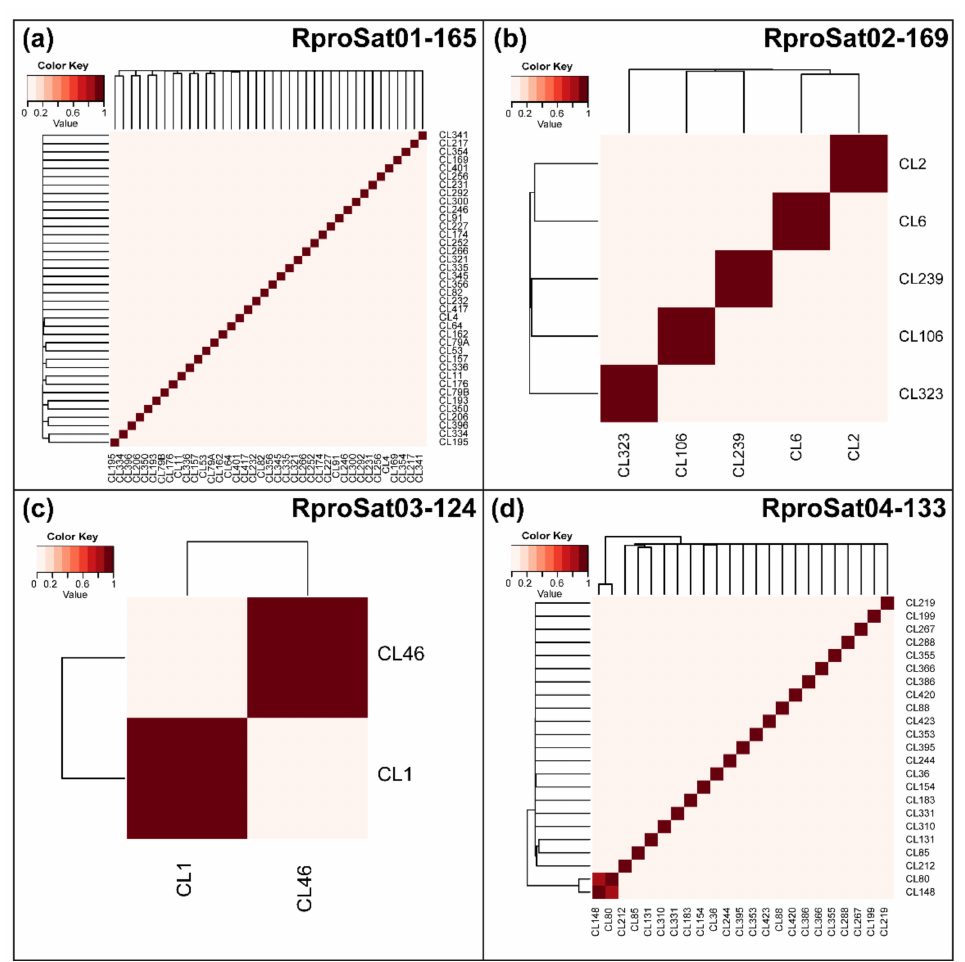
Figure 4. Heatmap representing the fraction of Rhodnius prolixus genome scaffolds shared by two subfamilies: ( a ) RproSat01- 165, ( b ) RproSat02-169, ( c ) RproSat03-124 and ( d ) RproSat04-133. The figure shows that almost no subfamilies coincide in the same